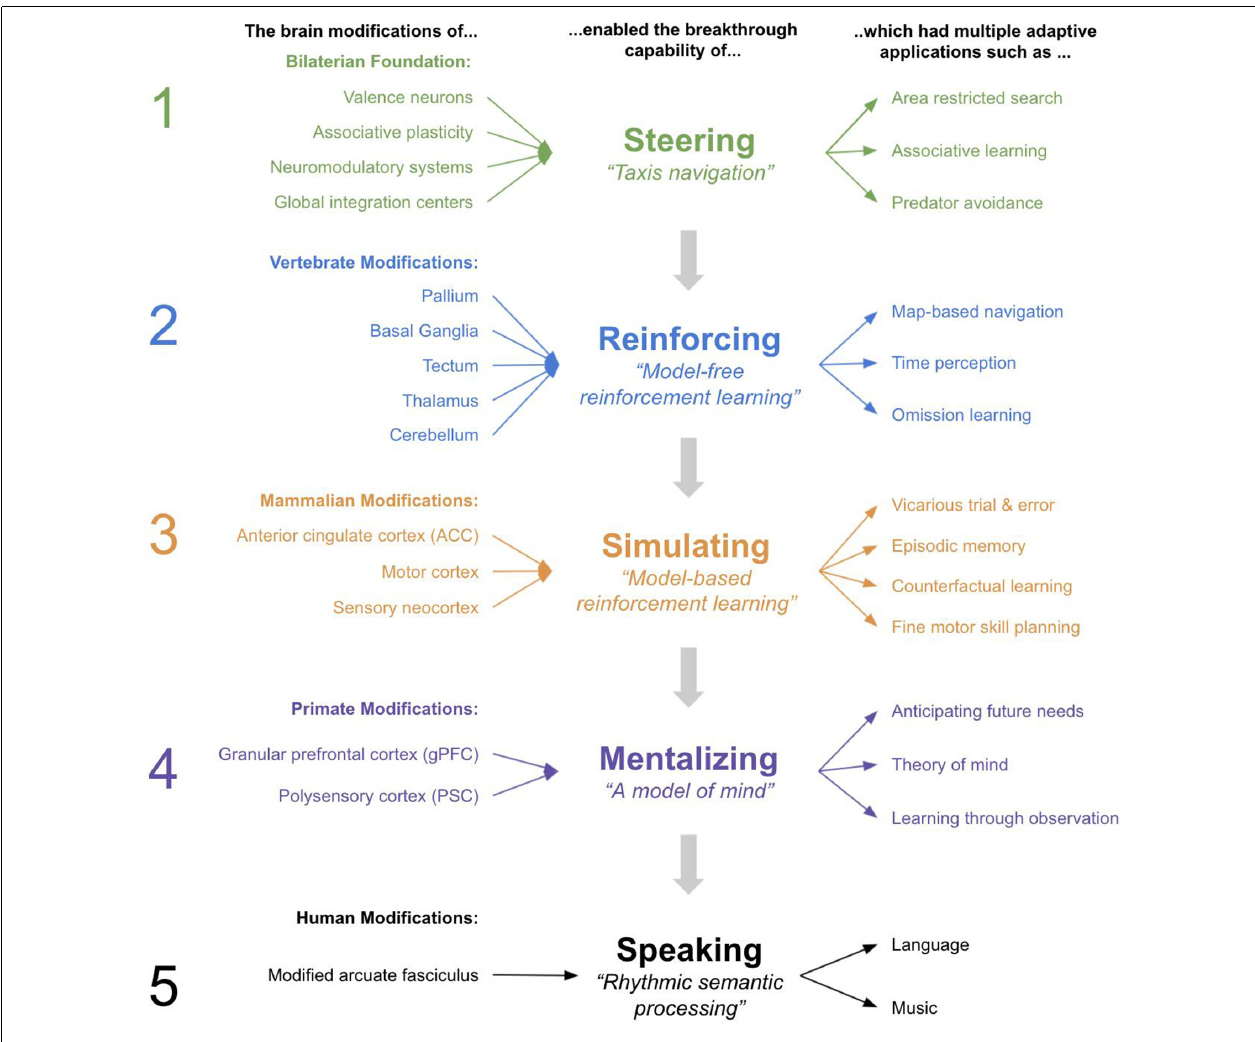
FIGURE 7 | Summary of the 5 Breakthroughs from early bilaterians to